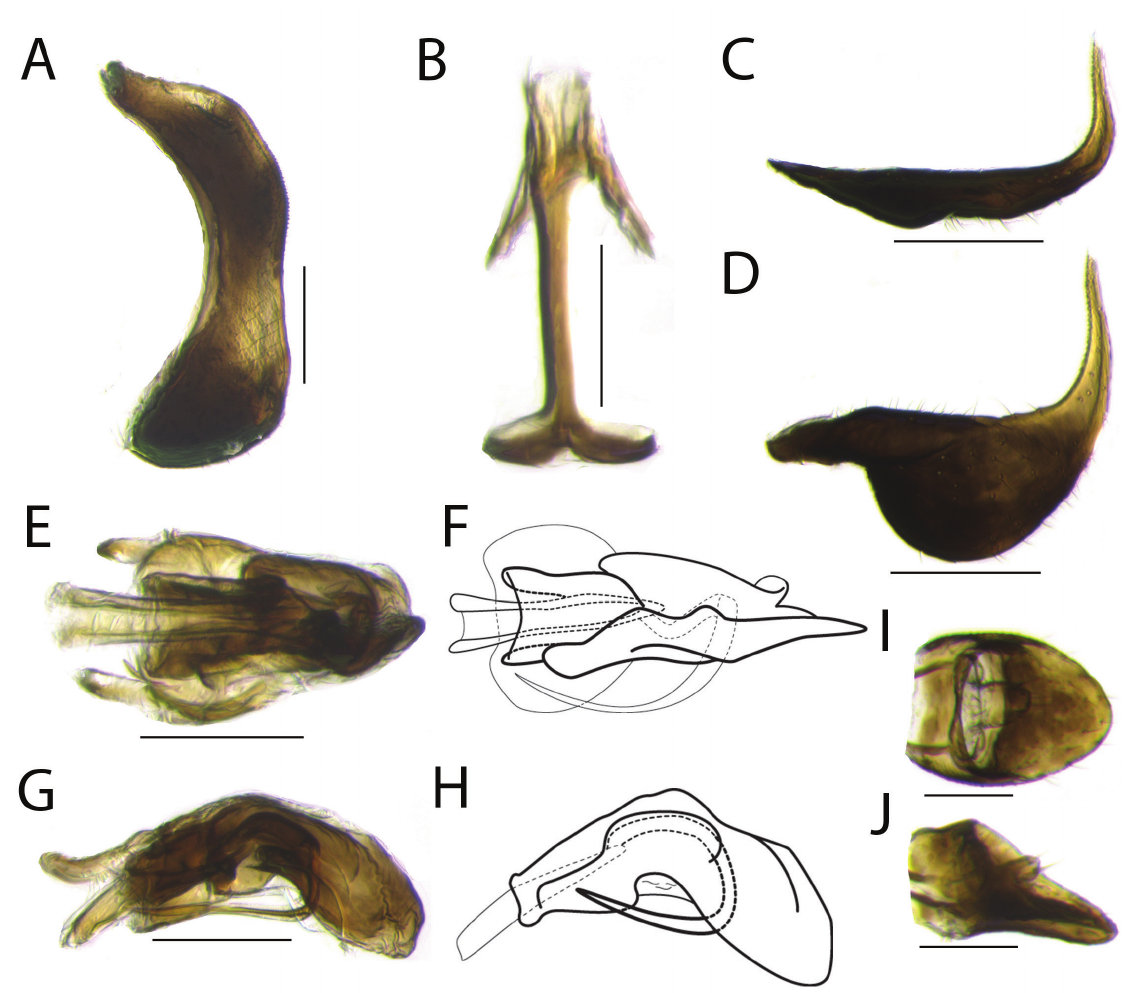
Fig. 25. Male terminalia of Protrocha punctatosa sp. nov., holotype (INHS). A . Pygofer, lateral view. B . Connective, anterior view. C–D . Style. C . Dorsal view. D . Lateral view. E–H . Phallus. E–F . Dorsal view. G–H . Lateral view. I–J . Anal tube. I . Dorsal view. J . Lateral view. Scale bars = 0.1